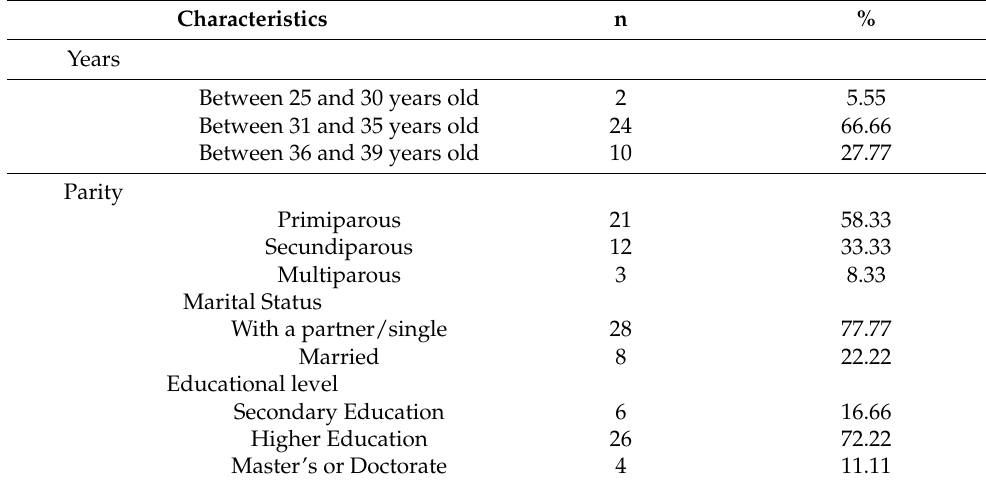
Table 2. Socio-demographic data of the